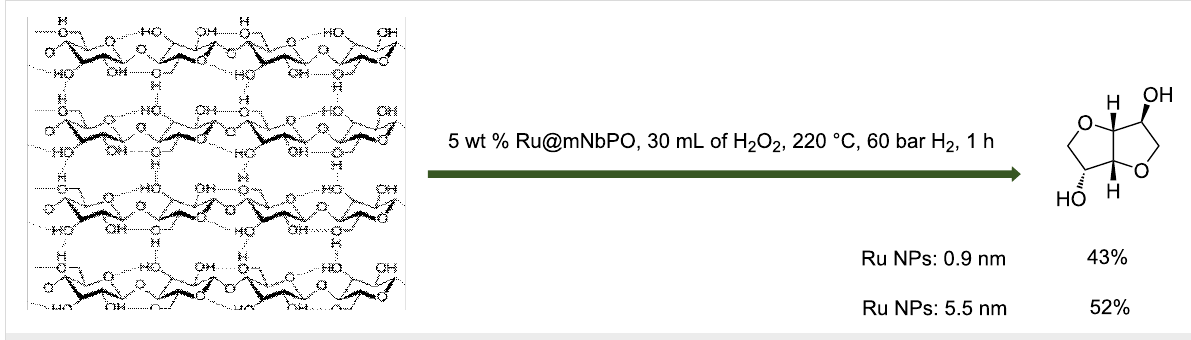
Scheme 7: Use of Ru-supported on mesoporous nobium phosphate (mNbPO) for the synthesis of isosorbide from cellulose [30].